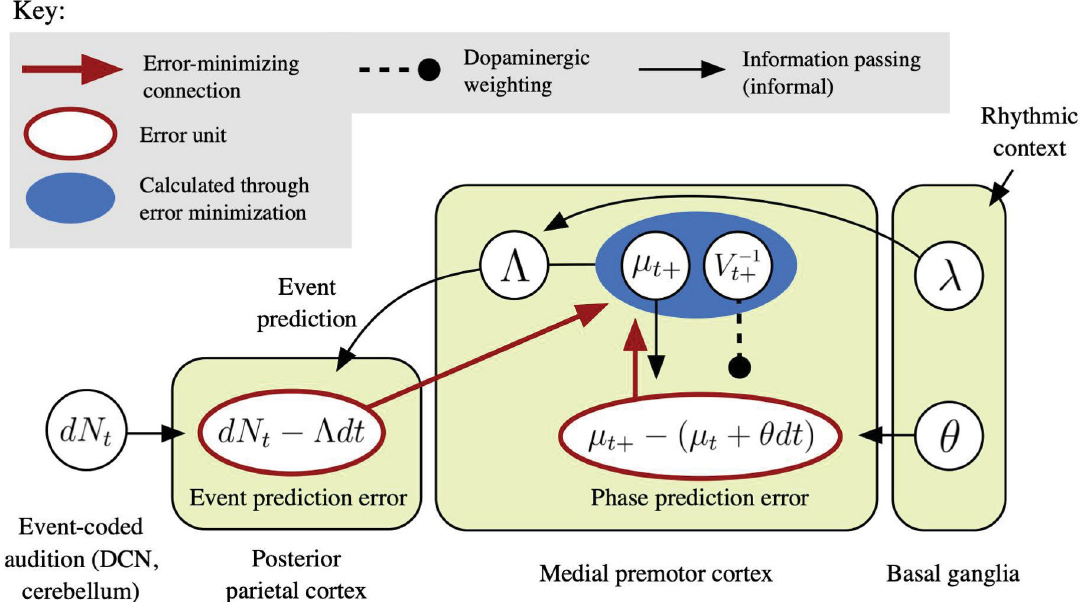
Fig 8. A possible implementation of PIPPET in the brain. This diagram embeds a formal predictive coding error minimization scheme is embedded within an informal information-passing schematic to outline how estimated phase μ might be calculated and t updated on each dt time step by a network of interacting brain regions. Estimated phase μ t and phase uncertainty V t are represented in medial premotor cortex (MPC). These estimates are used to calculate instantaneous subjective hazard rate Λ with the help of basal ganglia, which has selected an expectation template λ based on recent rhythmic context. The hazard rate is sent to parietal cortex, where it acts as a prediction of pulses rising from the event-based auditory pathway. An “event prediction error” signal comparing pulses to their prediction is sent back up to MPC, where it pushes μ in the direction that reduces prediction error—strongly toward local t + expectancy peaks when events occur, and weakly away from them when there are no events. (Note that phase updating at events is assumed to be rapid but not instantaneous as represented in the PIPPET filter.) The event prediction error is counterbalanced by a local “phase prediction error” signal generated through local interactions within MPC that pushes μ t + to continue its steady forward progress. Phase prediction error is weighted by dopaminergic signaling of state precision V (cid:0) 1 through t